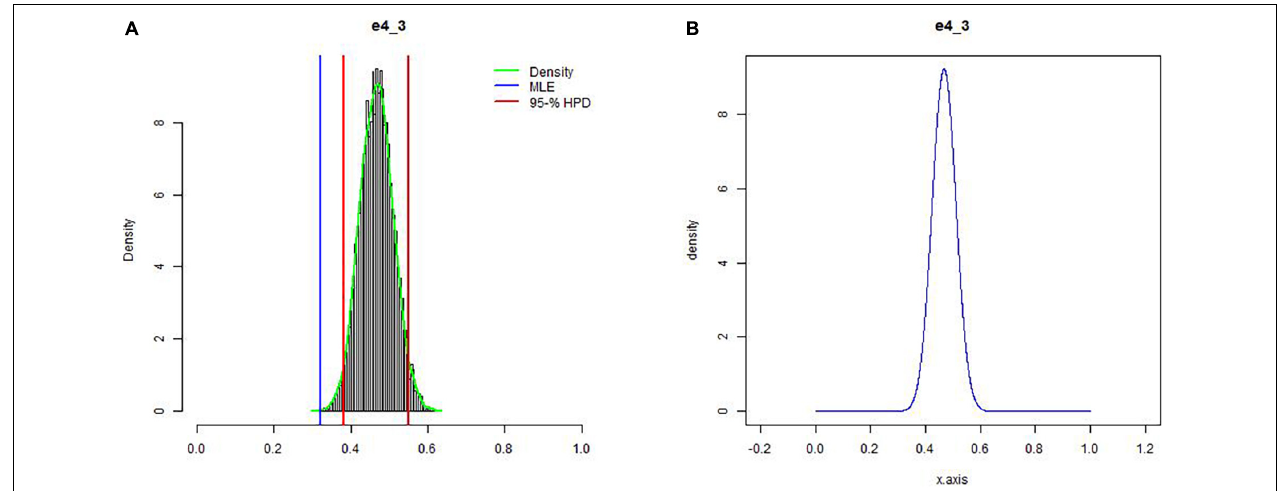
FIGURE 3 | (A) A histogram of predicted data is shown based on the prior derived from the expert (shown in B ). The red lines indicate the credibility interval of the prior predictive distribution, and the blue line the observed percentage. The probability value appeared to be < 0.001, showing there is a prior-data conflict. A table with results per expert can be found on the